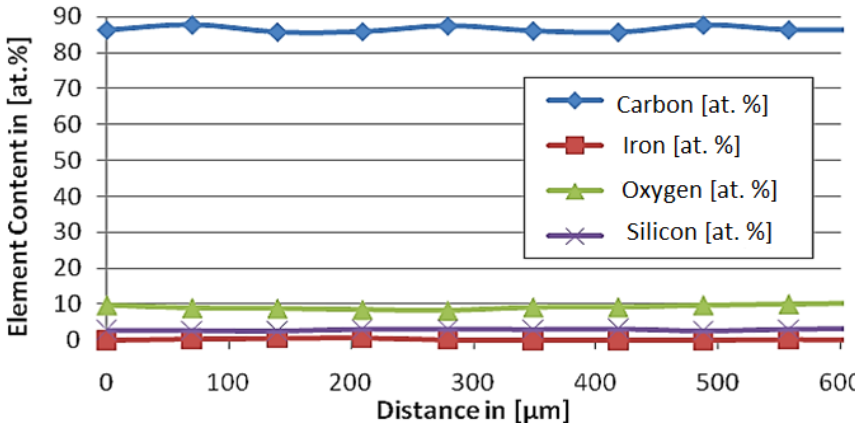
Figure 7. XPS scan of wear track profile of coating